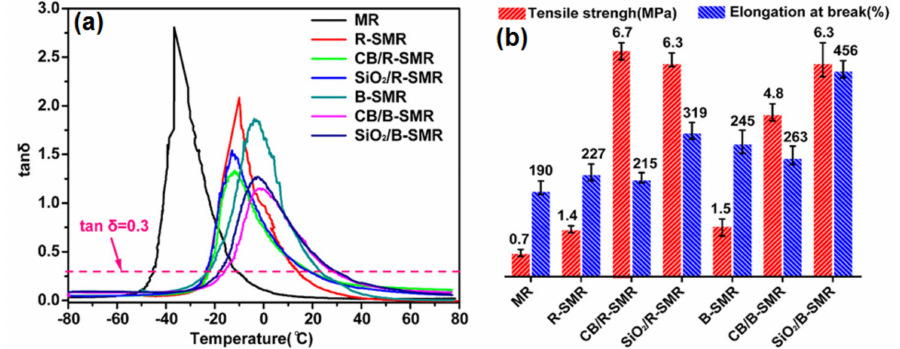
Figure 6. ( a ) Damping factor (tan δ ); ( b ) Tensile strength and elongation at break of all vulcanizates. Sample designations: ‘MR’ stands for homopolymer of β -myrcene, ‘SMR’ denotes copolymer of β -myrcene and styrene, ‘R and B’ before SMR indicates random and block, ‘CB and SiO black and Silica. (Reproduced from Reference 46, with permission from American Chemical